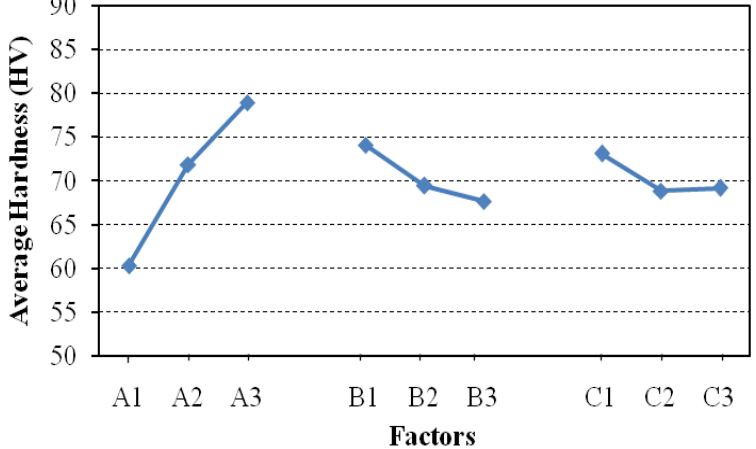
Figure 1. Main effects graph for ultimate tensile strength (UTS).